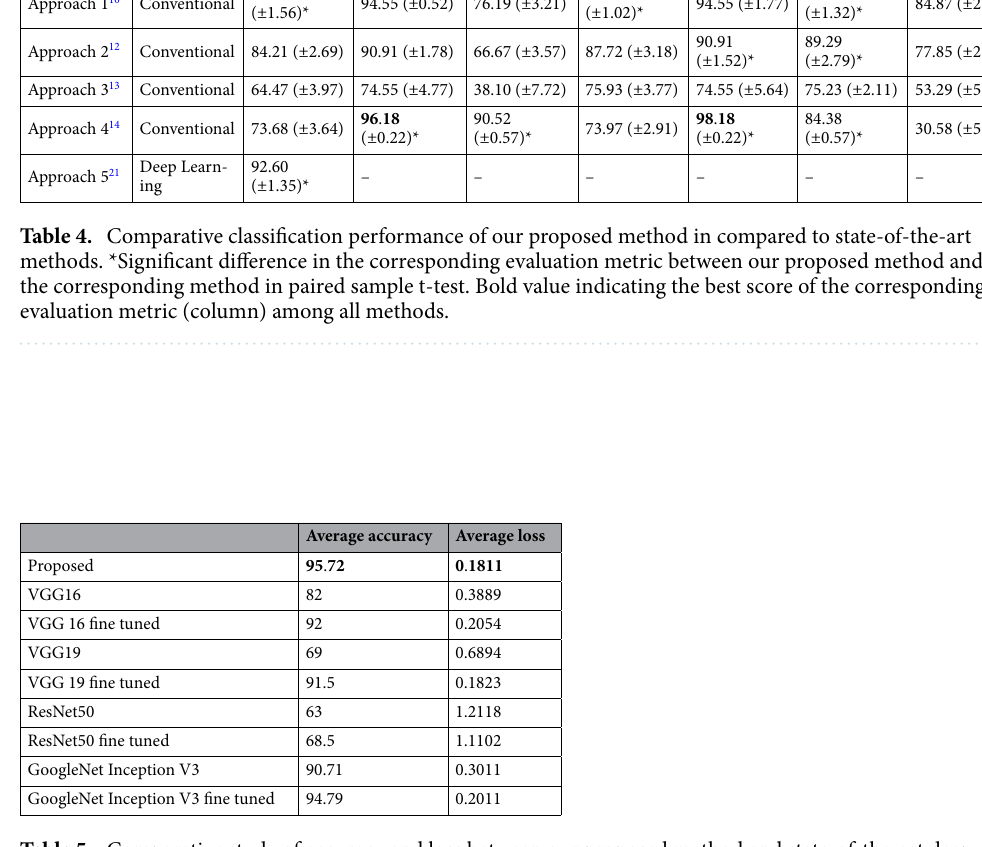
Table 5. Comparative study of accuracy and loss between our proposed method and state-of-the-art deep learning models. Bold value indicating the best score of the corresponding evaluation metric (e.g., accuracy or loss) among all